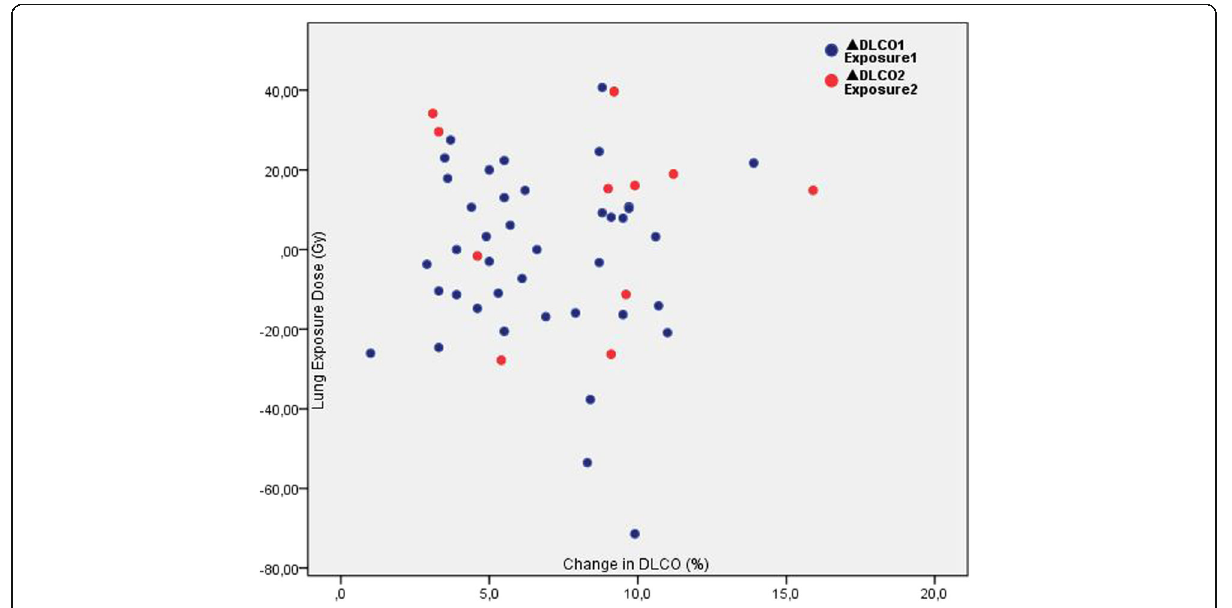
Fig. 1 Scatter plot of percent changes in diffusing capacity of the lung for carbon monoxide (DLCO) versus lung exposure dose (Gy)